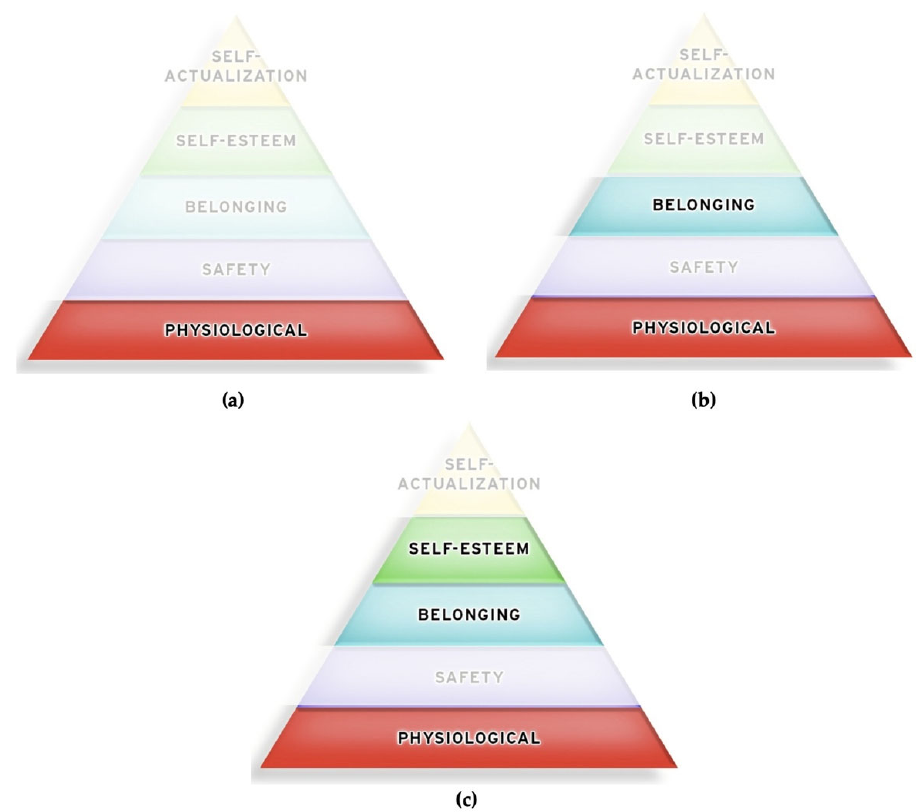
Figure 2. Experiencing multiple needs at the same time. ( a ) A person may be trying to meet their physical needs to survive; ( b ) At the same time, the person wants to take care of their family, feeling a sense of belonging; ( c ) That person can also feel a loss of self ‐ esteem and dignity because they cannot take care of their family the way they want to. As a possible correction, there is another option to represent these multiple needs. As shown in Figure 3, instead of a pyramid, a sphere can represent the multiple needs that a person may experience at the same time. Here, the boundaries between different needs are not absolute, they are blurred and fluid. As a person copes with multiple needs, their experience moves closer to the center of the sphere [40].